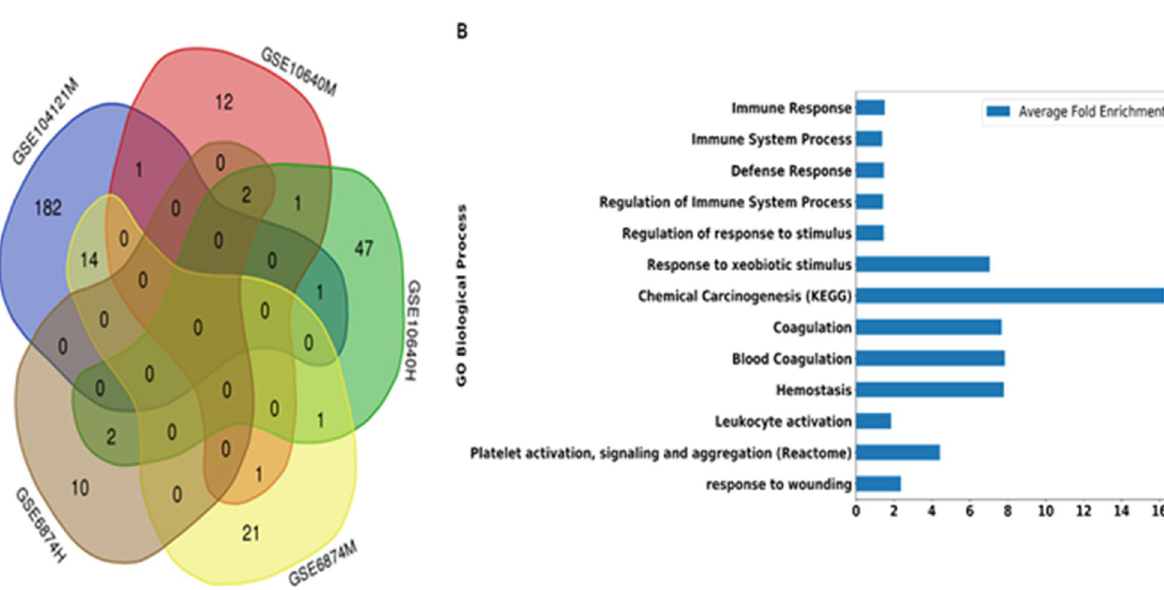
Figure 2. Comparison of enriched biological pathways among different networks. ( A ) Overlap of the Gene Ontology terms (Biological Processes, Molecular Functions, and Cellular Compartments) and pathways (KEGG pathways, Reactome pathways, BioCyc) in each network based on 5% False Discovery Rate (FDR). The venn diagram was created using http://bioin forma tics.psb.ugent .be/webto ols/Venn/14 ( B ) Average fold enrichment of biological processes and pathways that were enriched in more than one